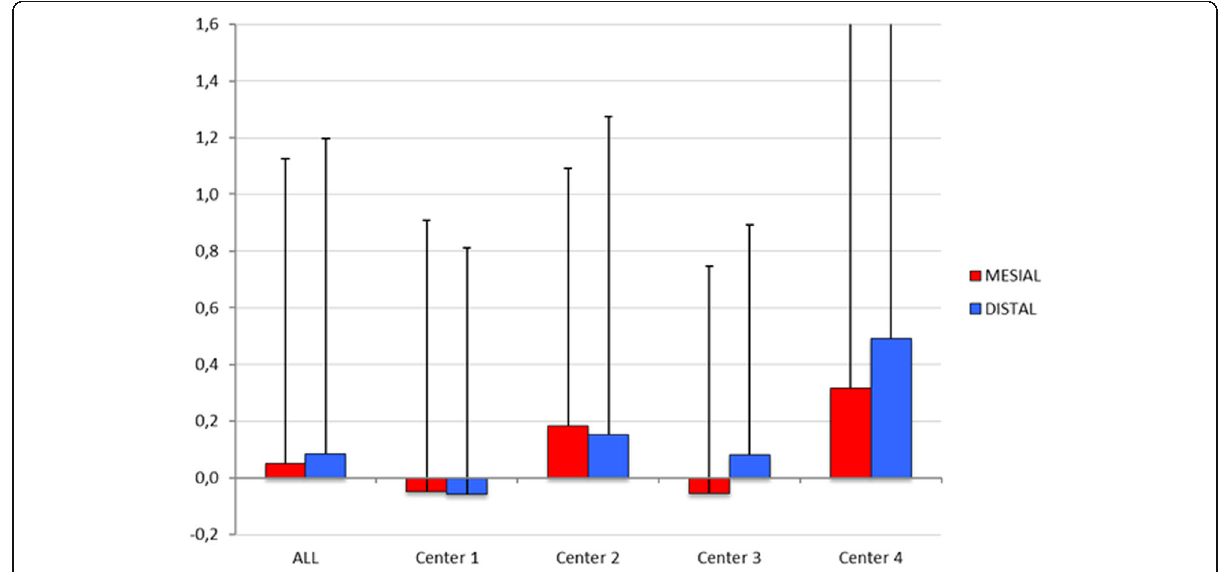
Fig. 4 Data distribution of marginal bone loss/gain between T0 (implant insertion) and T2 (last recall) of each